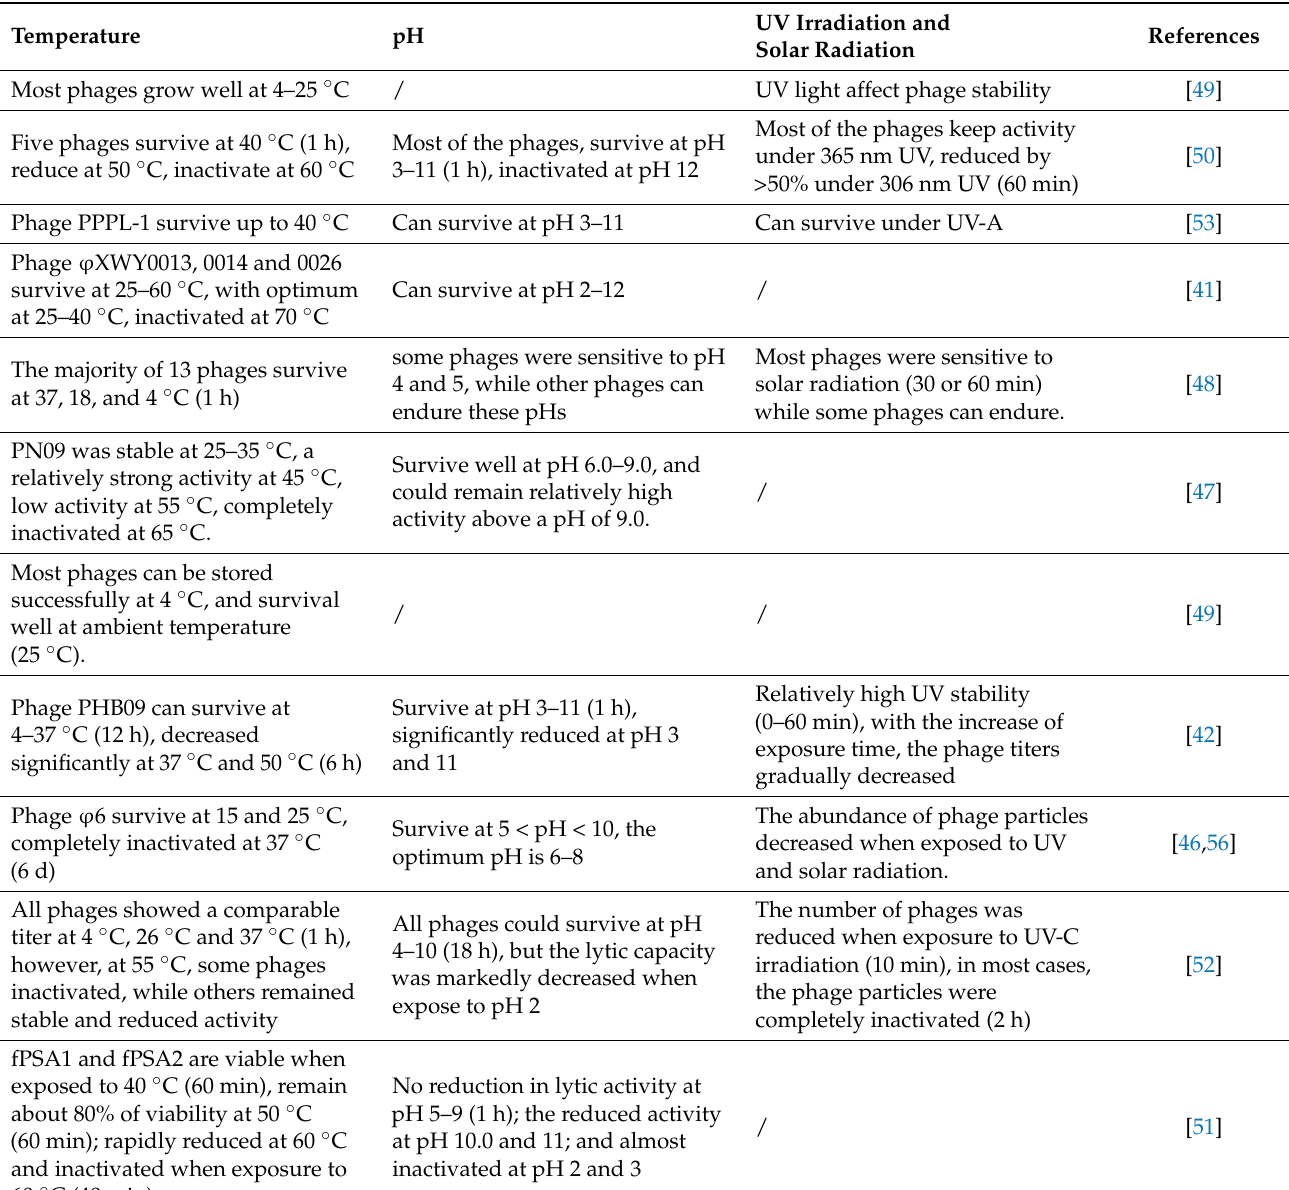
Table 5. Phage tolerance to various environmental